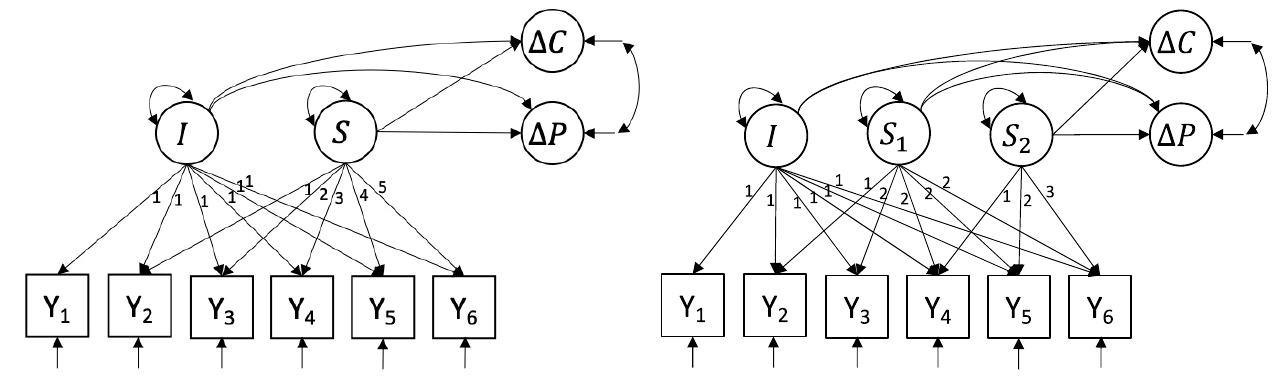
Figure 2. The linear LGCM ( left ) and the piecewise LGCM ( right ). Y = daily measurement of PTSD symptomatology using the 8-item PCL; I = intercept growth factor; S = linear slope growth factor; S 1 = linear slope growth factor week 1; S 2 = linear slope growth factor week 2; Δ𝐶 = difference in CAPS-5 before and after treatment; Δ𝑃 = difference in PCL-5 before and after treatment.